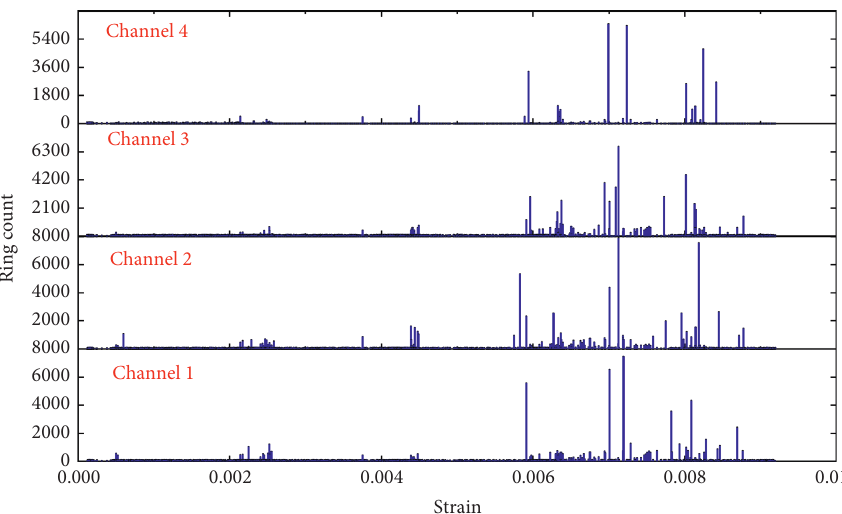
Figure 6: Relationship curve between cumulative ring count and